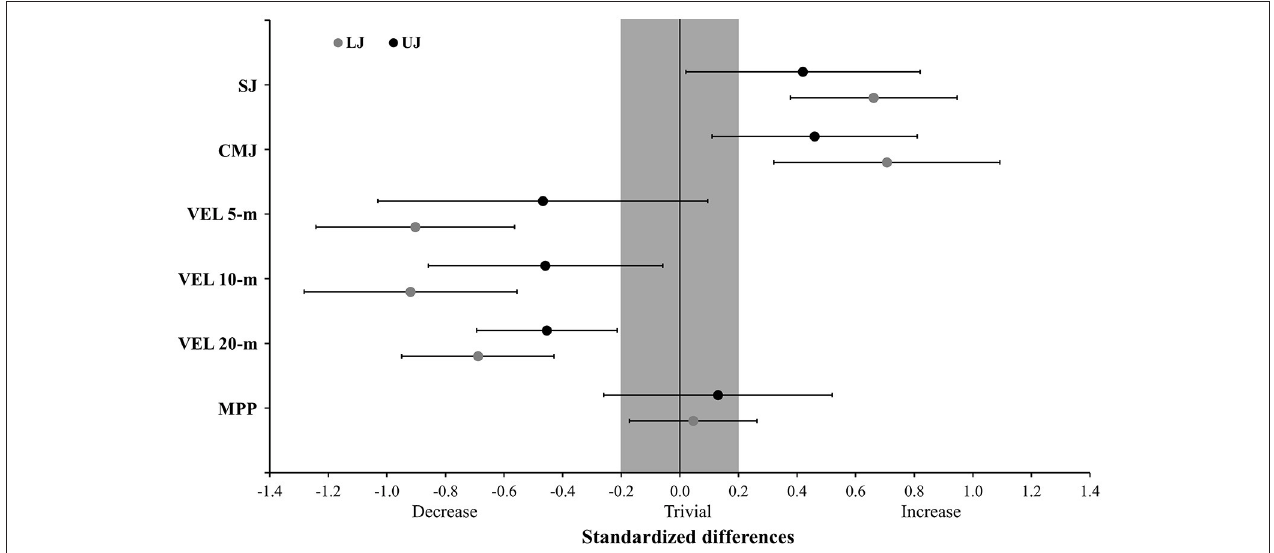
FIGURE 1 | Standardized differences of the performance tests comparing pre- and post- the 6-week preseason period in young soccer players. LJ, loaded jump group; UJ, unloaded jump group; SJ, squat jump; CMJ, countermovement jump; VEL, velocity; MPP, maximum mean propulsive power relative to the players’ body mass; error bars represent 90% confidence limits; gray area represents the smallest worthwhile change based on Cohen’s units (effect size >